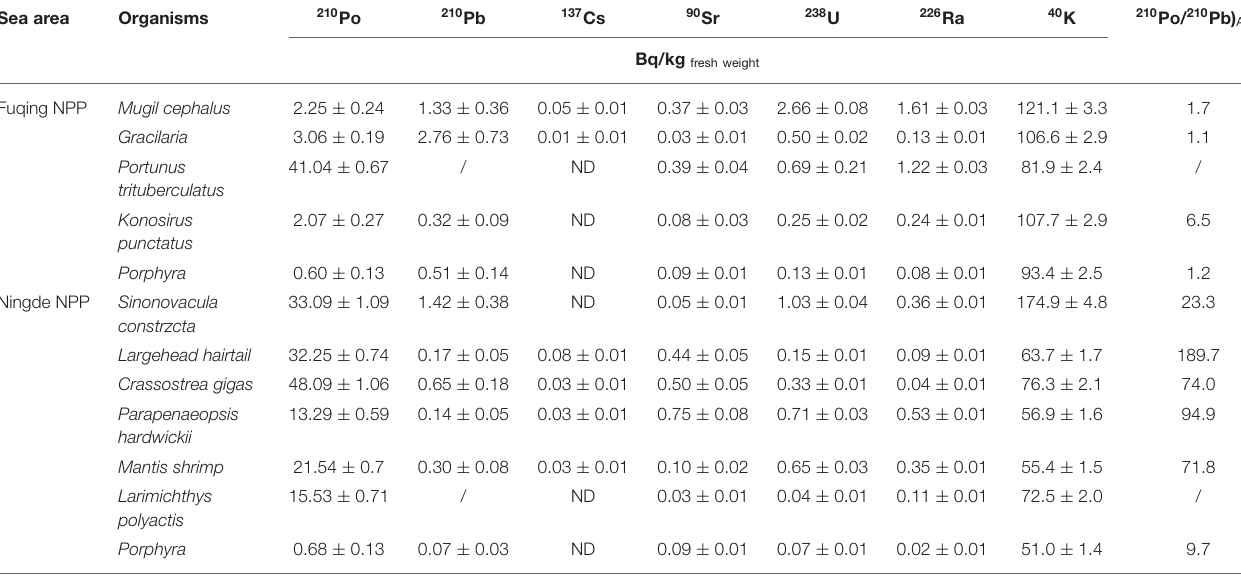
TABLE 2 | Activities of 210 Po and 210 Pb and other radionuclides in marine organisms sampled in this study. Sea